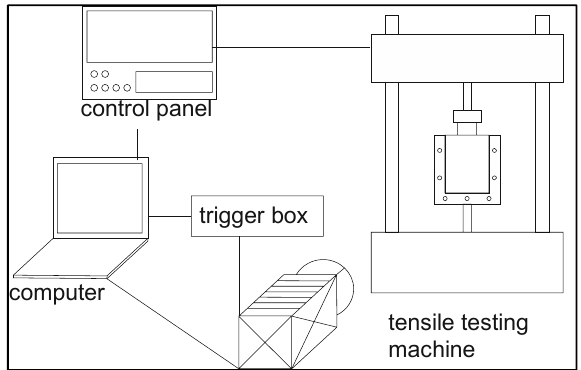
Figure 3. Scheme of the experimental set-up.